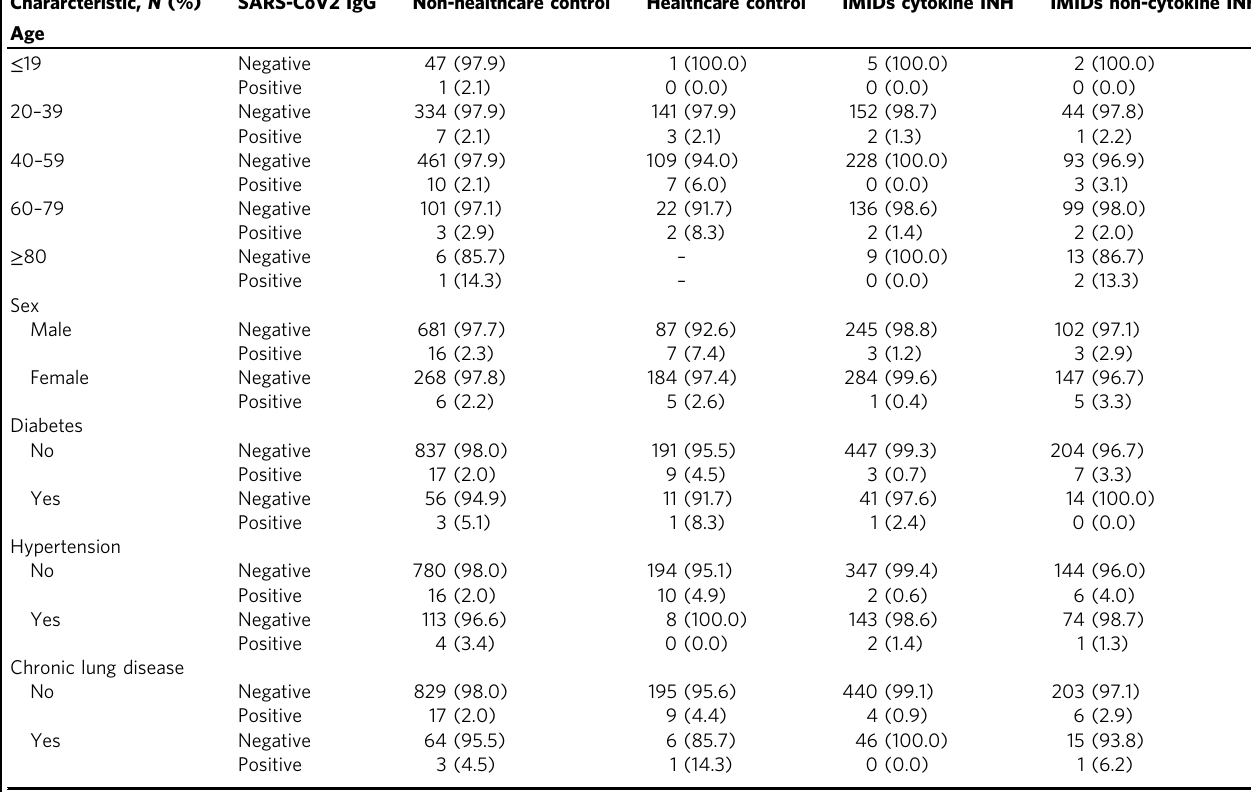
Table 2 Seropositivity strati fi ed by group, age, sex, and comorbidity. Chararcteristic, N